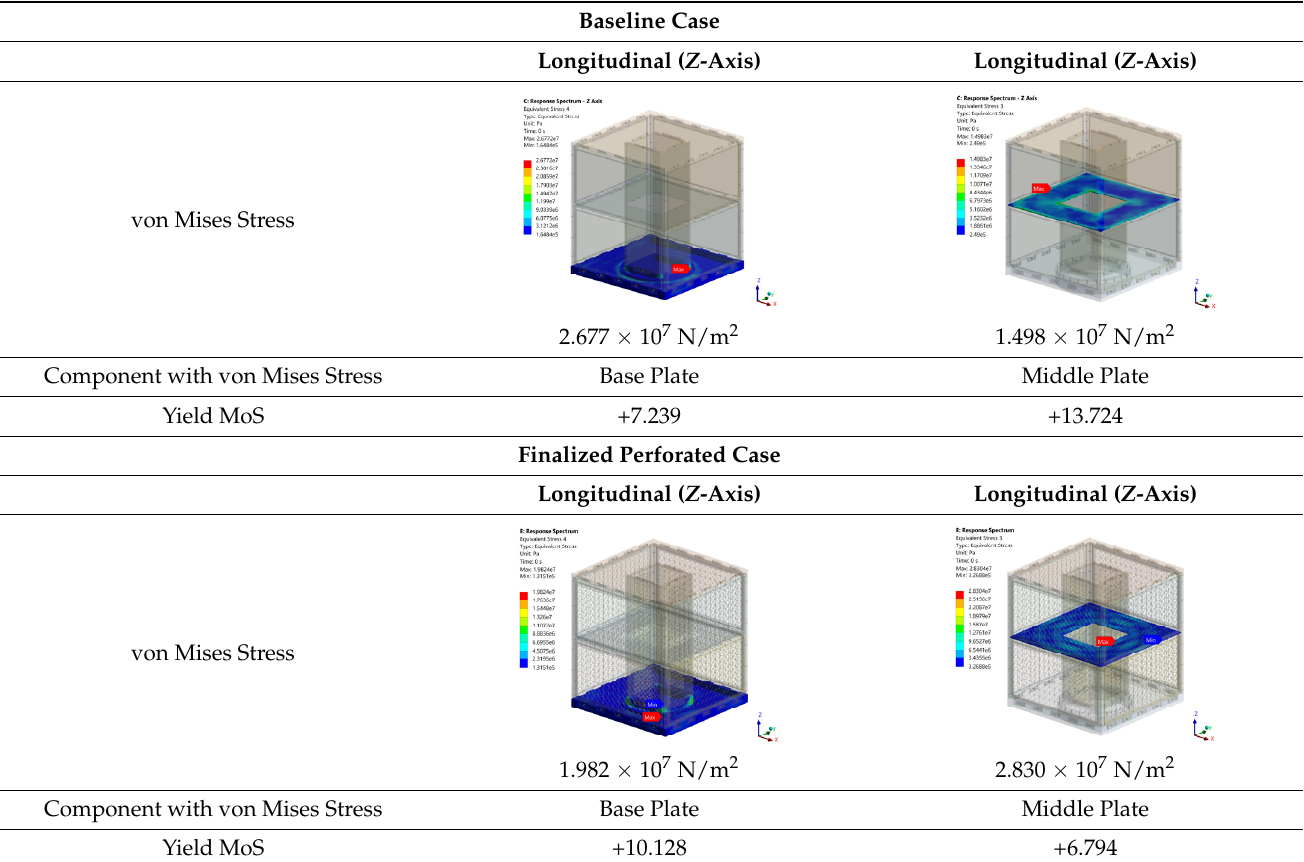
Table 9. Baseline and perforated shock launch loads—von Mises stresses, longitudinal direction.